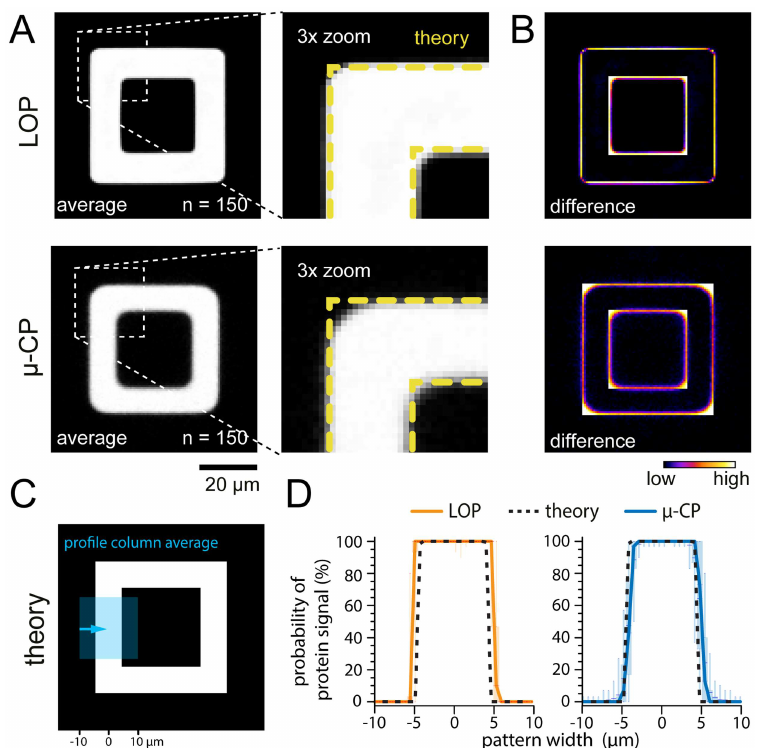
Fig 3. Comparison of pattern accuracybetween LOP and μ CP methods. (A) Average images of 150 binarizedprotein patterns created by LOP and μ CP on 25 kPa gels. (B) Differenceimages calculatedby comparing the averageimages and the theoreticalpattern mask. Edges and corners are resolved substantially better in patterns created by LOP. (C) Theoretical pattern shapewith a regionhighlighted corresponding to where profile column averagescans were taken. (D) Profile column averagescans across 150 binarized patterns show that the variationin protein signal at the pattern edges is strongly reducedin LOP patterns. Plotted are the median(line), 1 st / 3 rd quartile(box) and 5–95%(whisker) of the probabilityof protein present across the pattern